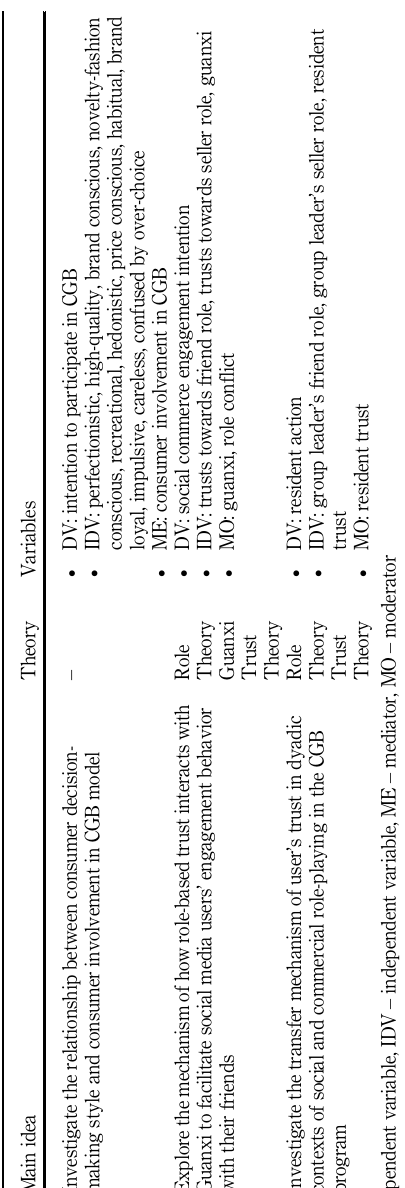
Table 1. Comparison of existing relevant literature with this